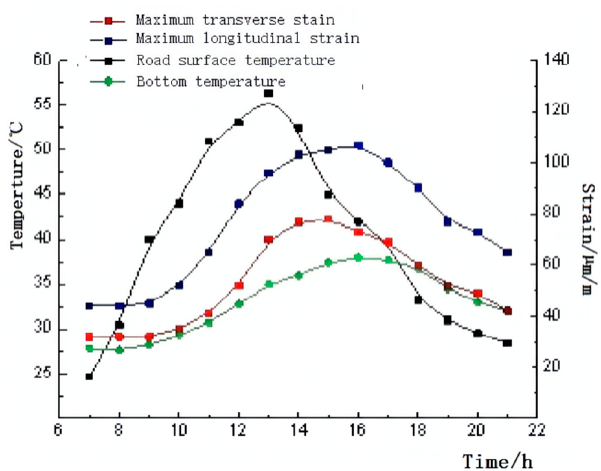
Figure 6. Structure A temperature versus maximum tensile strain in the transverse and longitudinal direction at the base of the layer.